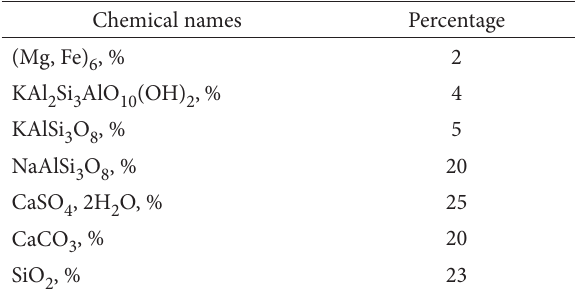
Table 1. Results of chemical analysis on the studied soil